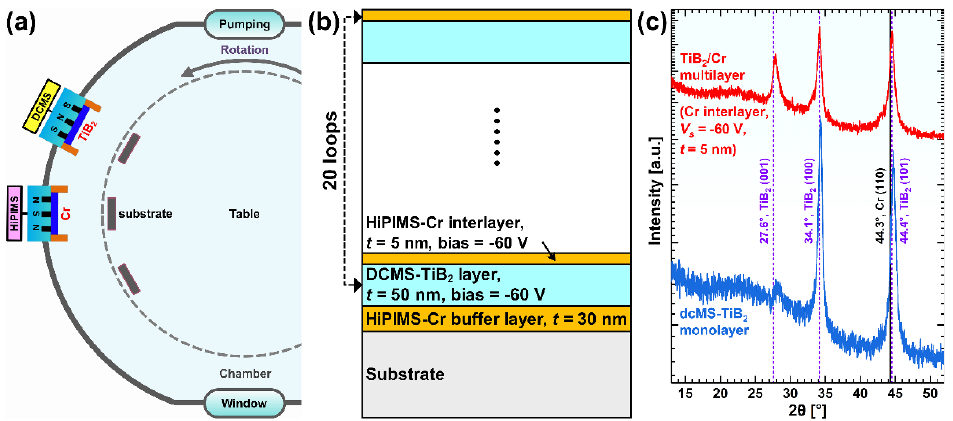
Figure 1. Schematic diagrams of ( a ) Cr-HiPIMS/TiB 2 -dcMS sputtering deposition system and ( b ) TiB 2 /Cr multilayer. ( c ) presents θ -2 θ XRD patterns of TiB 2 /Cr multilayer film. Table 1. Detail parameters for deposition of TiB 2 /Cr multilayer film.